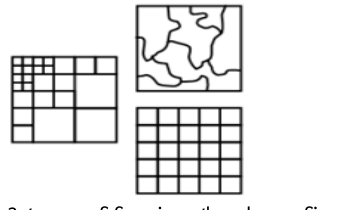
Figure 3 types of fencing, the above figure, multi-scale and left, the four-and-down tree,